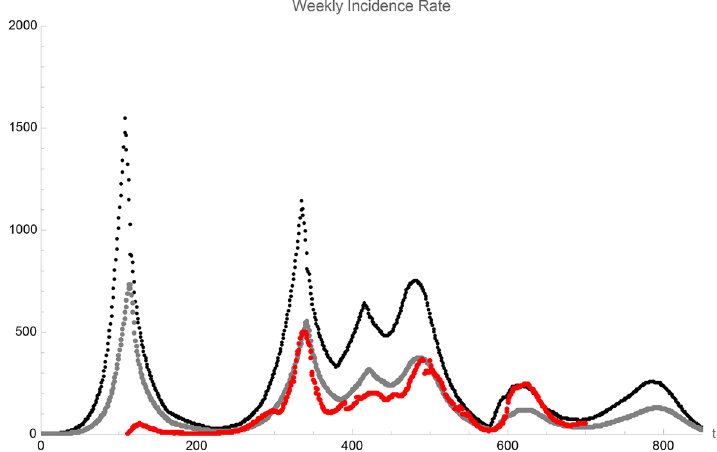
Figure 3. Incidence rate, sumed up over the preceeding week, as calculated in our model with symptomatics as well as asymptomatics infected persons (black points) or with symptomatic ones only (gray poins) as compared to data from 18 (red points). The origin of time, t = 0, corresponds to December 1,2019.